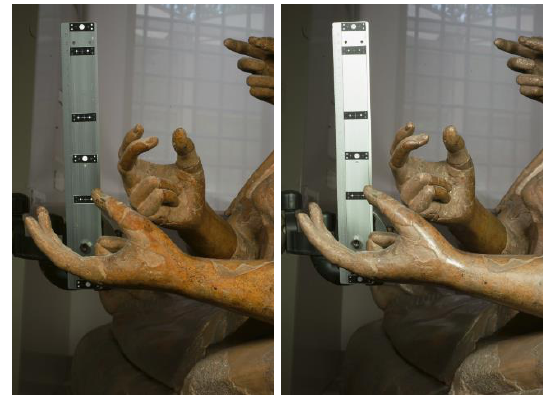
Figure 5. A test image of the hands and a scale bar acquired with (left) and without (right) cross